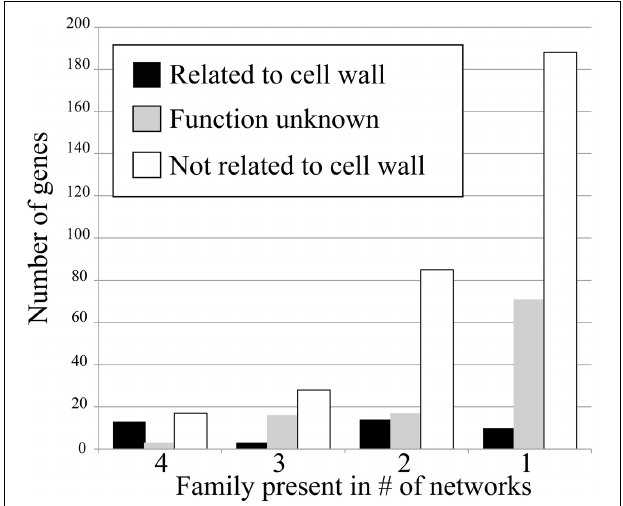
FIGURE 2 | Number of cell wall-related genes in the four conservation classes. Genes that are cell wall related (Mapman ontology term 10) are shown in black, genes with unknown function (term 35) are shown in gray, and genes not related to cell wall (any term but 10 and 35) are shown in